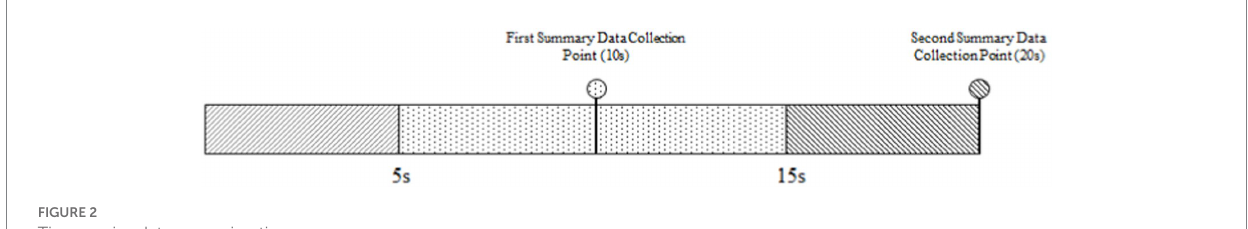
FIGURE 2 Times series data